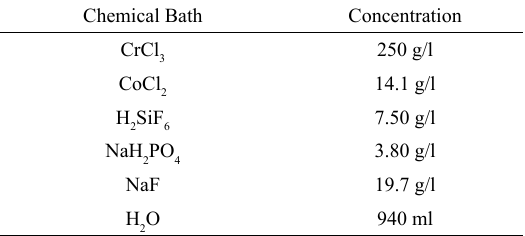
Table 1. Chemical bath for electrolytic deposition Chemical Bath